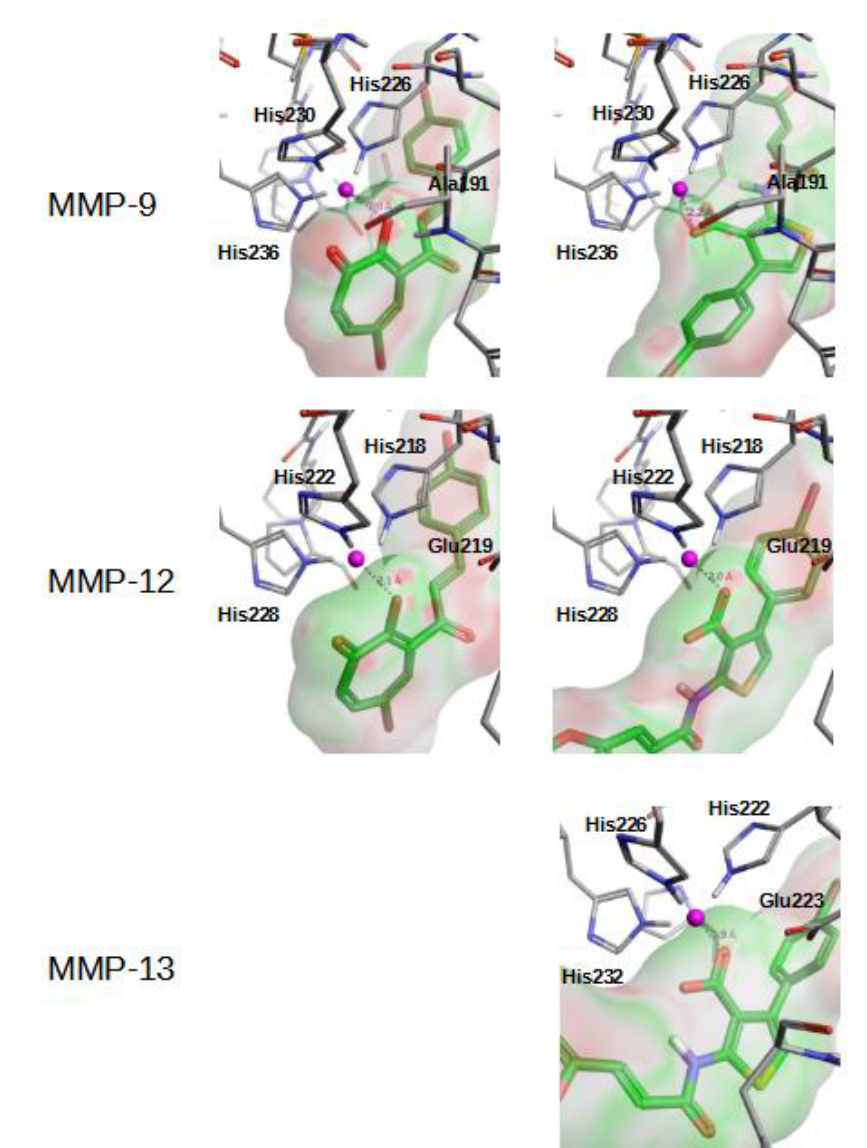
Figure 3. Best docking poses for hit compounds 3 and 6 at the Zn 2+ binding site of MMP-8, MMP-9, MMP-12 and MMP-13. The docked poses for the 3 /MMP-13 pair is not shown because this was not predicted to be possible by the corresponding VS